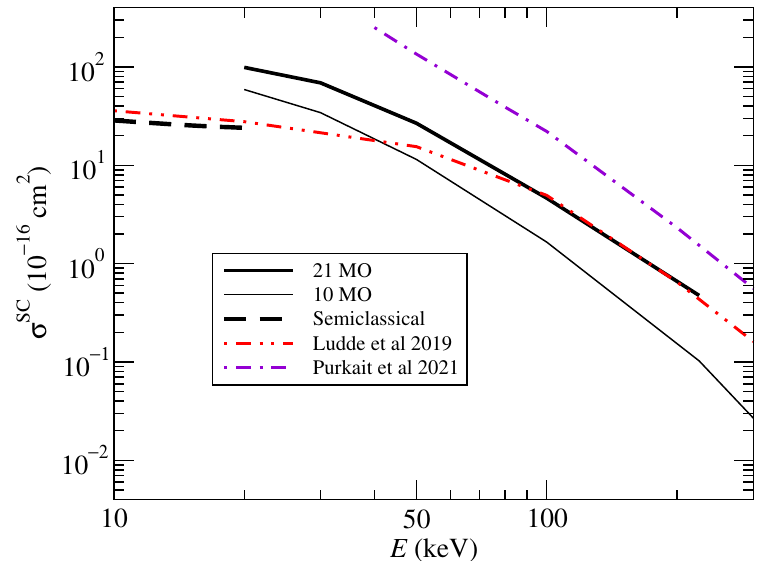
Figure 9. Cross sections for single charge transfer in proton–uracil collisions as functions of the collision energy. The present CTMC results (21 MO and 10 MO) are compared with those of Lüdde et al. [20] and Purkait et al. [15] and with the semiclassical results shown in Figure